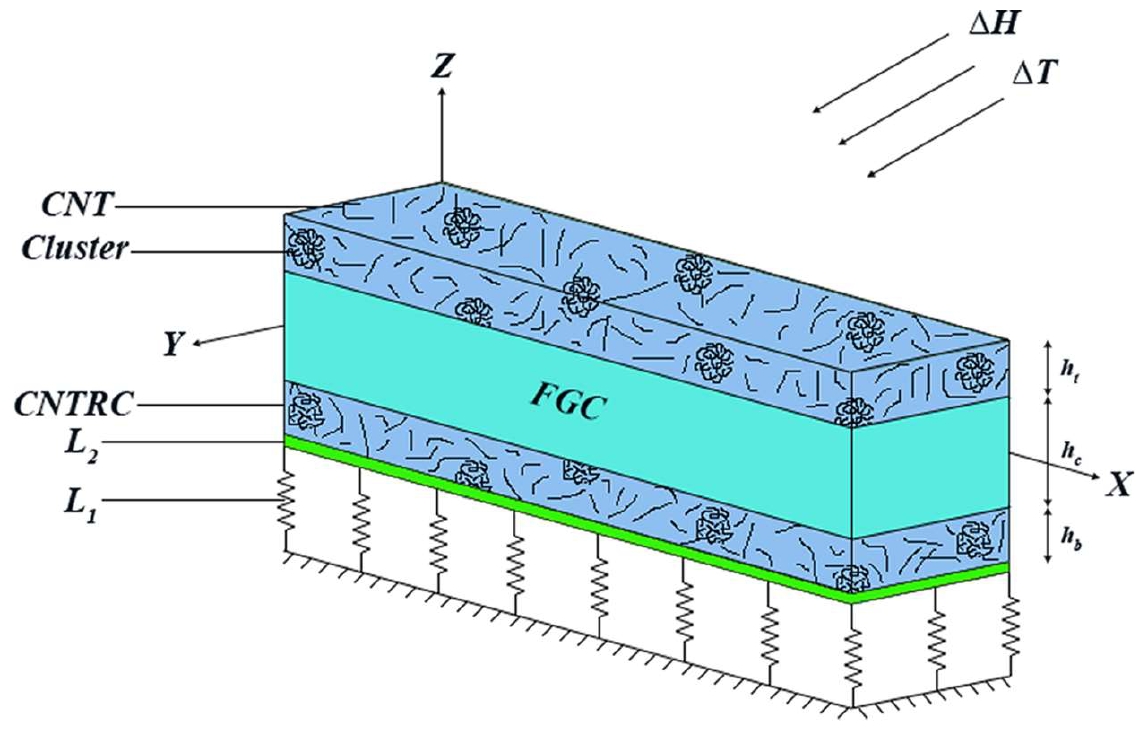
Figure 1. Sandwich beam model.